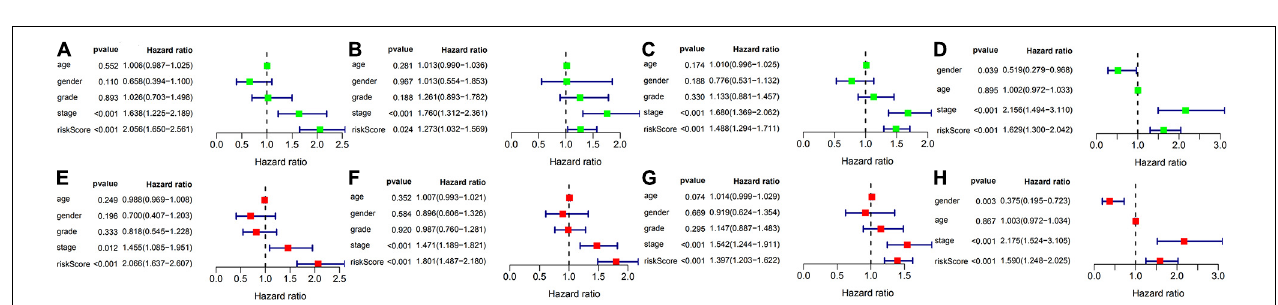
FIGURE 4 | Evaluation and validation of the risk score of the 6-ARGP signature. Survival analysis and ROC analysis based on risk score in the training set (A,E,I) , test set (B,F,J) , TCGA set (C,G,K) , and ICGC set (D,H,L) , respectively.